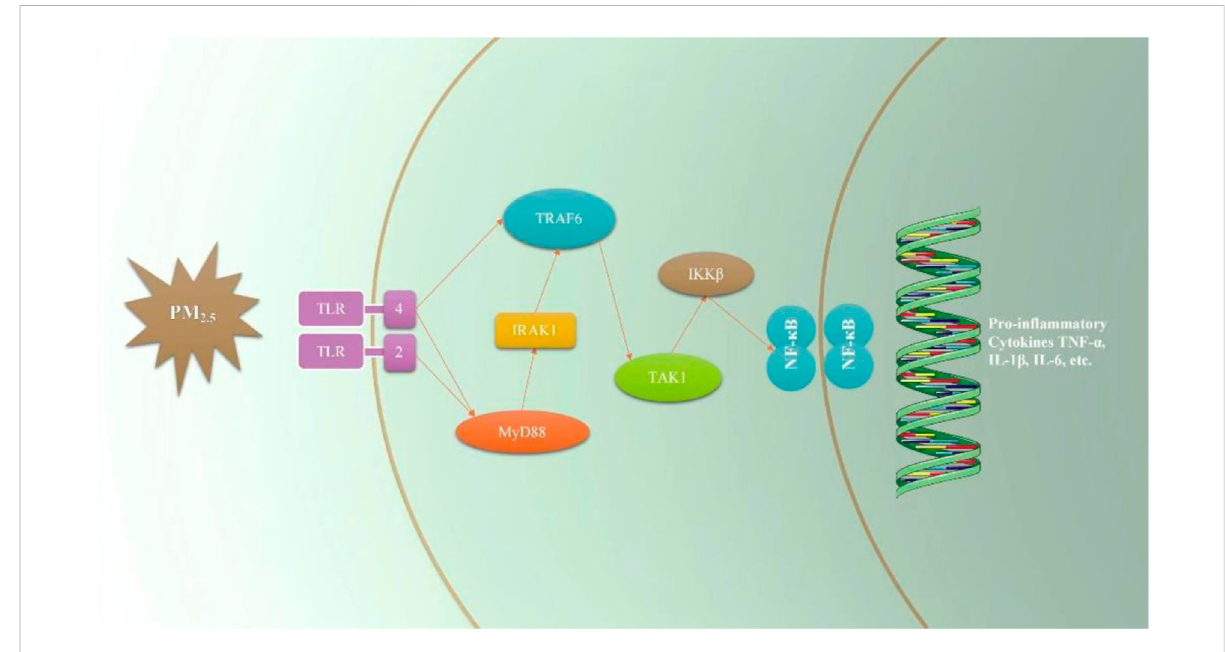
FIGURE 9 Sketch of the effect of PM 2.5 on TLRs signal